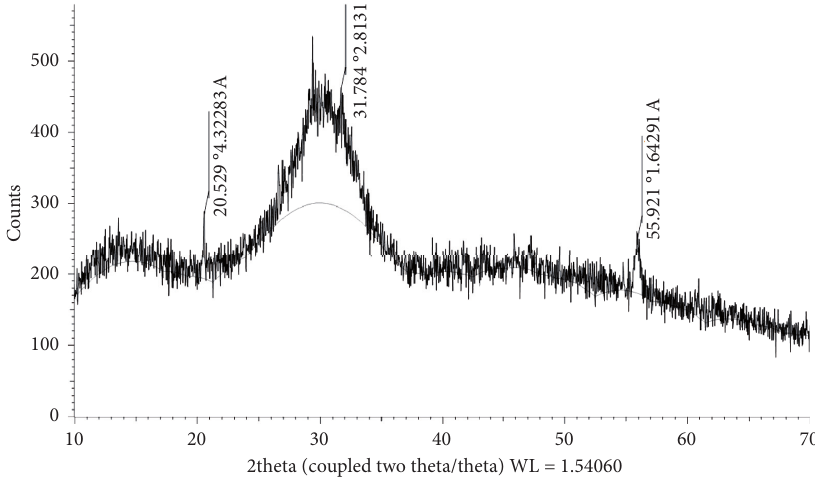
Figure 5: XRD pattern of the YPS2